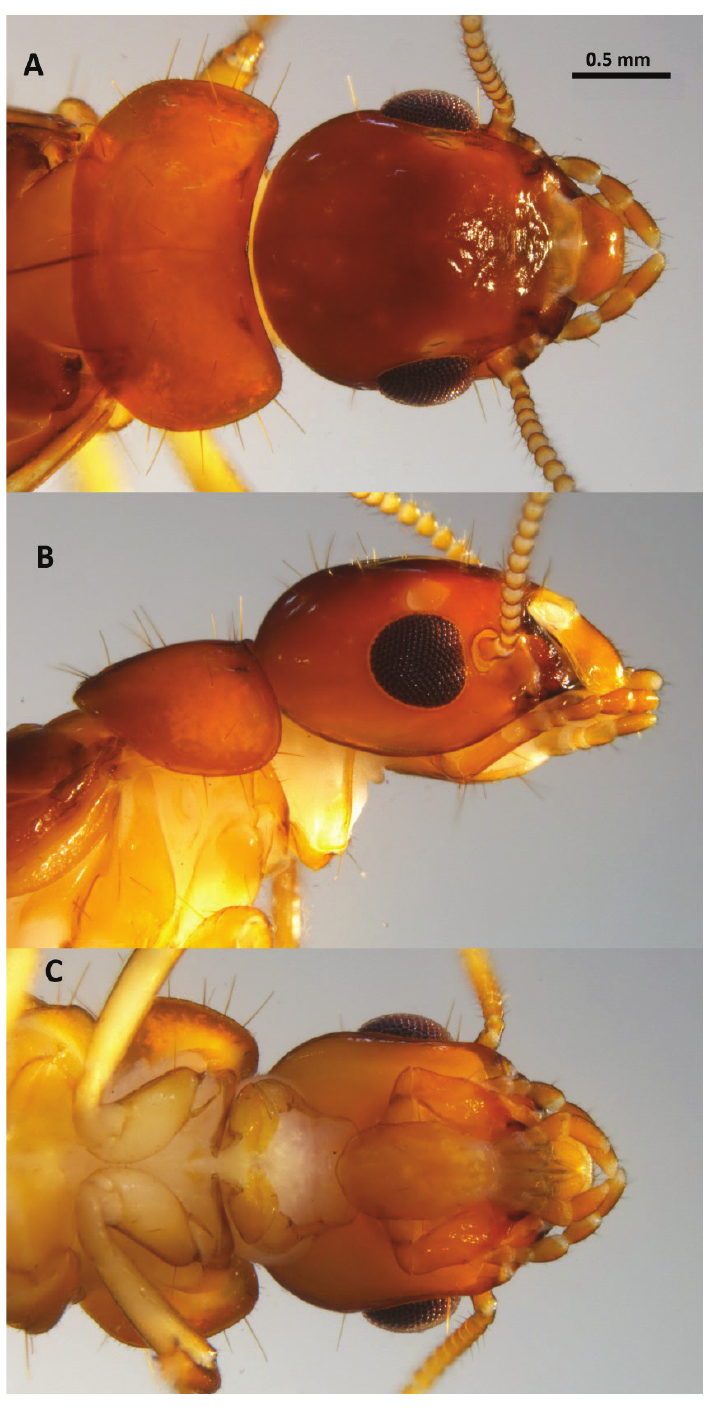
Figure 1. Head and thorax of Neotermes aburiensis imago. A Dorsal B lateral, and C ventral